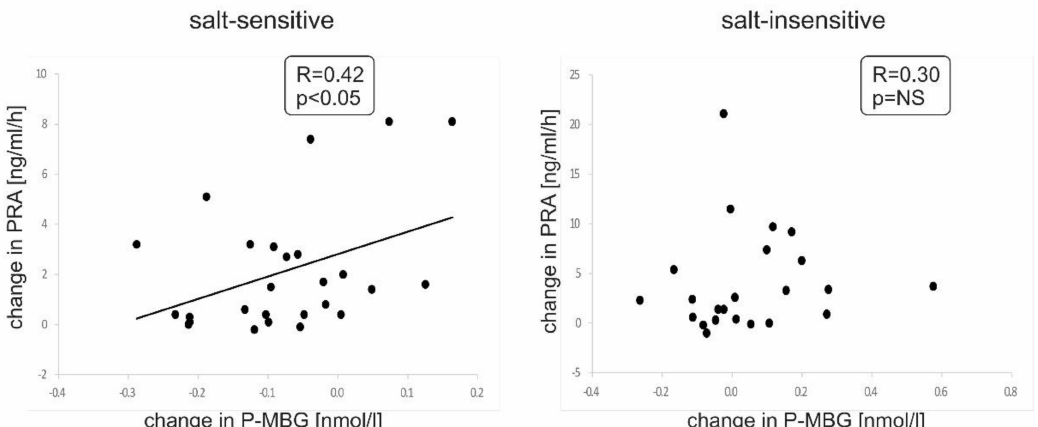
Figure 4. Correlation between changes in plasma MBG ( p -MBG) from baseline to the end of salt restriction and changes in plasma renin activity (PRA) from baseline to the end of salt restriction in salt-sensitive and salt-insensitive groups,